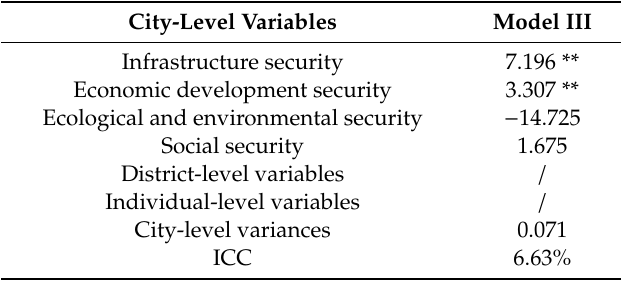
Table 4. Results of the FPHEB’s PUPS in “city–individual”